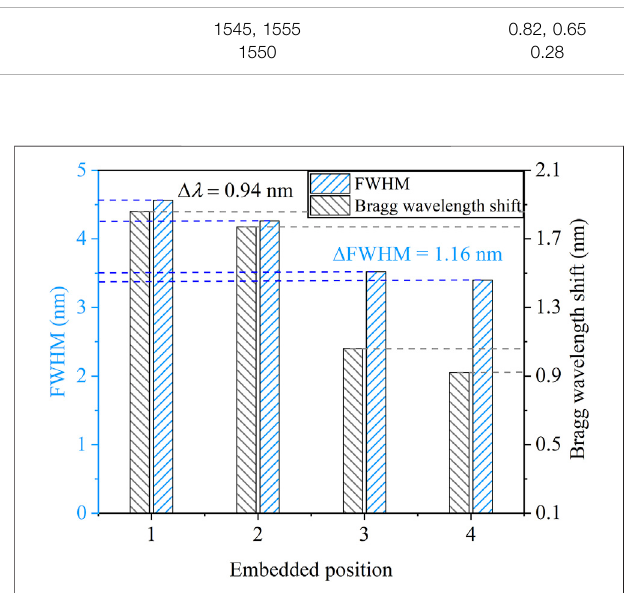
FIGURE 12 | Monitoring and discrimination of the asymmetric deformation re fl ected by the FWHM and Bragg wavelength shift of FBGs.